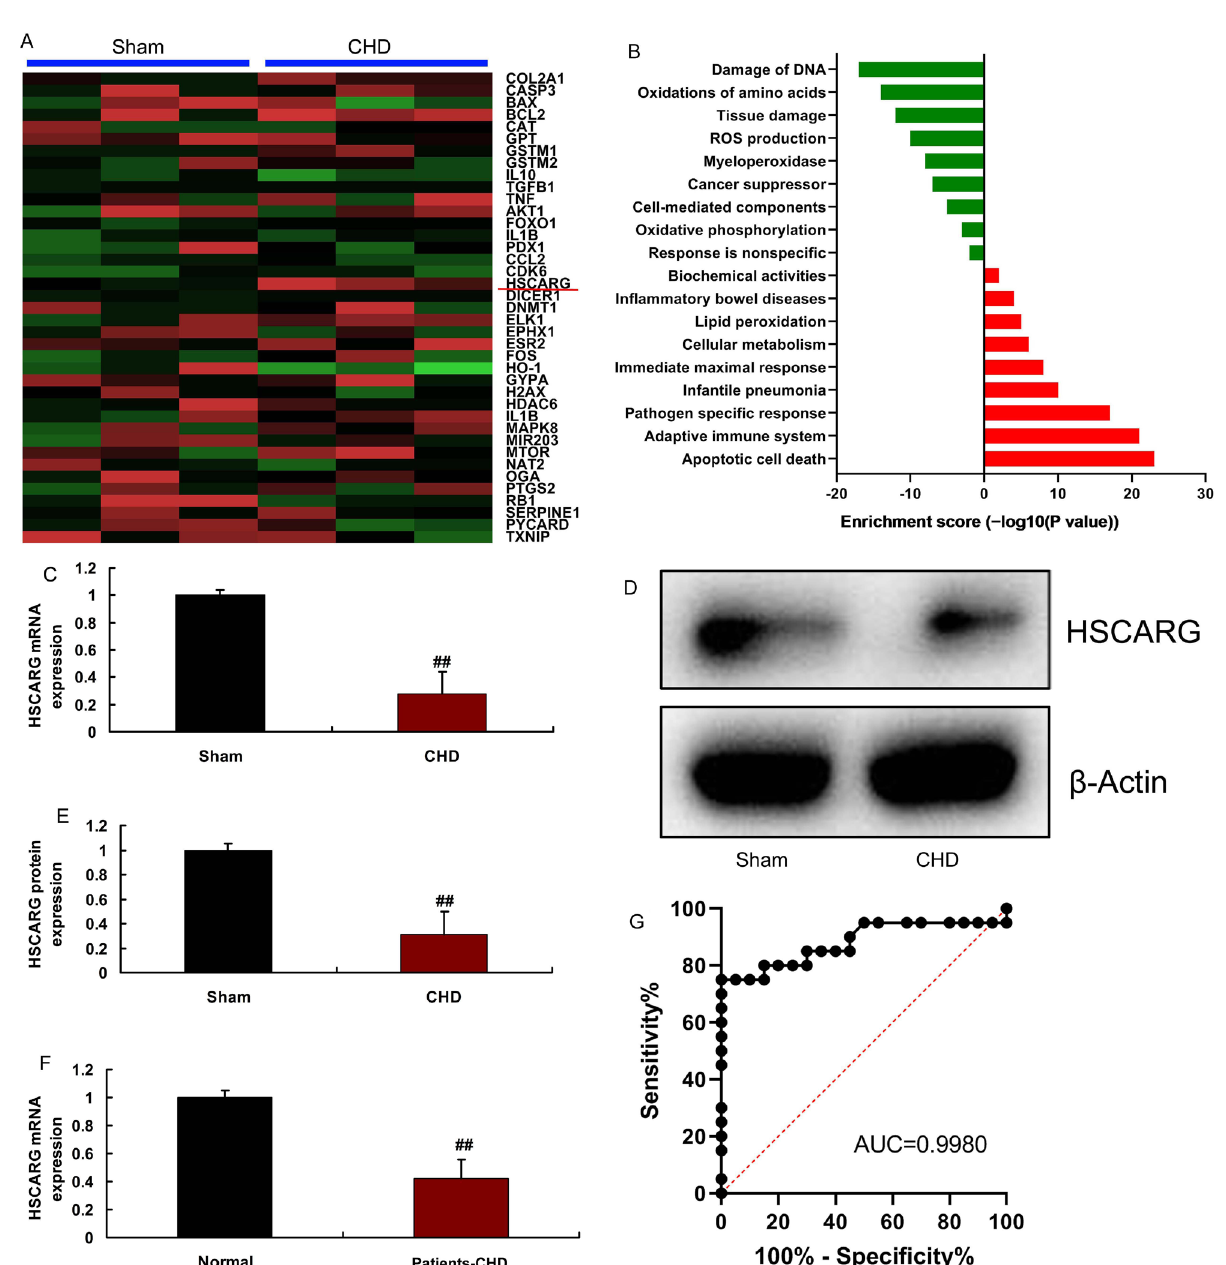
Fig. 1 - HSCARG expression in patients with atherosclerotic coronary heart disease (CHD) or mice model. Heat map and microarray data (A and B), HSCARG messenger ribonucleic acid (mRNA) and protein expression in mice model of CHD (C, D and E), serum HSCARG mRNA in patients with CHD (F), and sensitivity analysis (G) in patients with CHD. Sham=sham control group; CHD=mice model of CHD group; normal=normal volunteers group; patients-CHD=patients with CHD group. ##P<0.01 compared with sham control group or normal volunteers group. AUC=area under the curve; DNA=deoxyribonucleic acid; ROS=reactive oxygen species model. We found that overexpression of HSCARG reduced of HSCARG suppressed HSCARG protein expression and p47phox and p-NF-κB expression in in vitro model, which may induced p47phox and NF-κB protein expressions in in vitro be an important target (Figure 4). Immunofluorescence showed model (Figure 5B, that HSCARG suppressed p47phox expression in in vitro model (Figure 5A). Overexpression of HSCARG induced HSCARG protein expression and suppressed the protein of p47phox and p-NF-κB expressions in in vitro model (Figure 5B-5E). And downregulation 730 Brazilian Journal of Cardiovascular Surgery